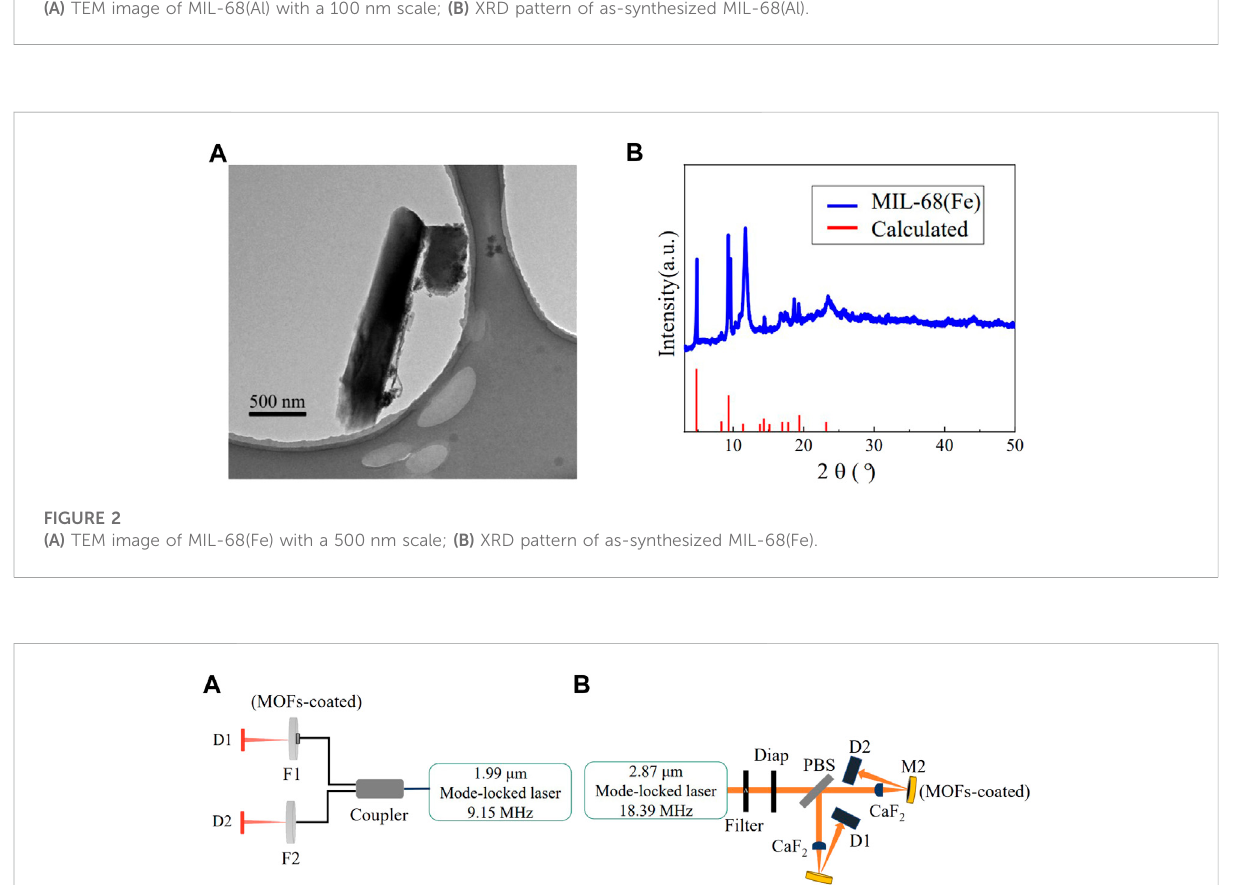
a ( 1 + 1 ) × 1 pump combiner. The fi ber circulator guaranteed the one-way light propagation in the ring cavity with de fi nite light propagation direction (1 → 2 → 3). In addition, the port-2 pigtail of the circulator was vertically cut to the fi ber axis and